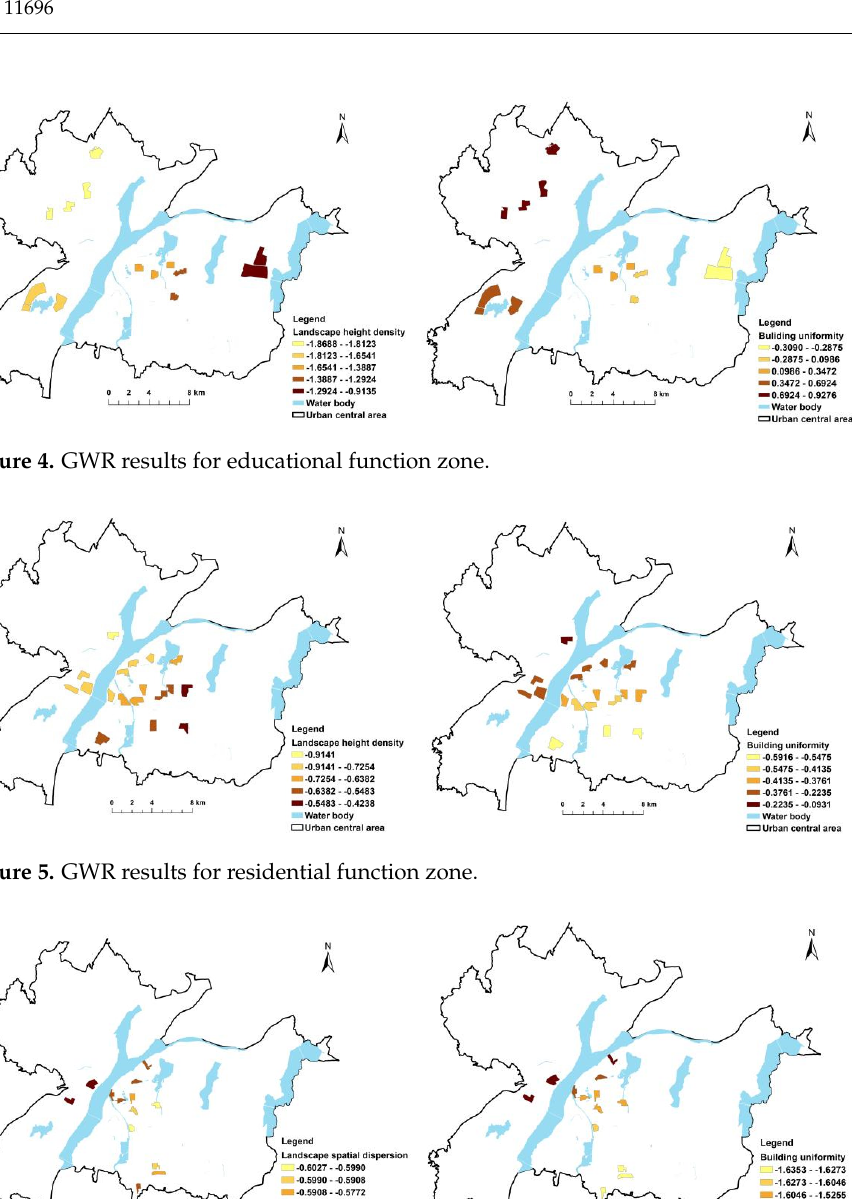
Figure 3. GWR results for industrial function zone.